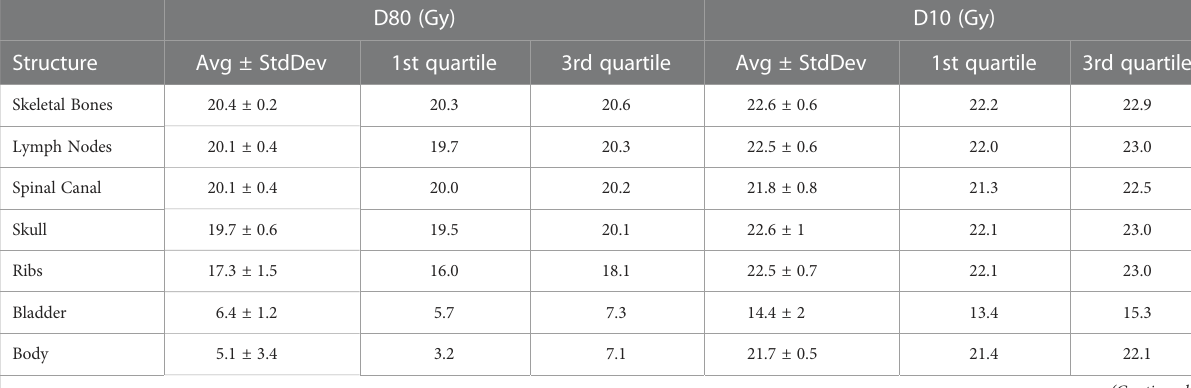
TABLE 3 Statistics of D80 and D10 for each structure with the 20-Gy